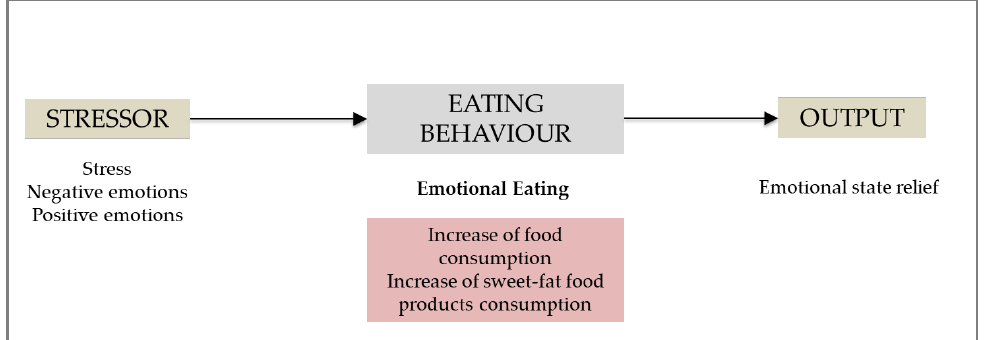
Figure 1. Emotional eating mechanism.